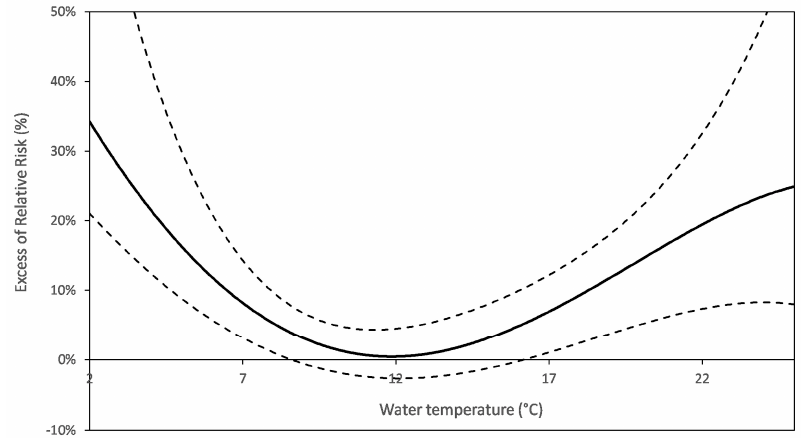
Figure 5. AGE risk function for the water temperature (PA-Nord). The right branch may miss (e.g., Boston). The delay considered for the health response to the river flow is homogenous with that used for turbidity.